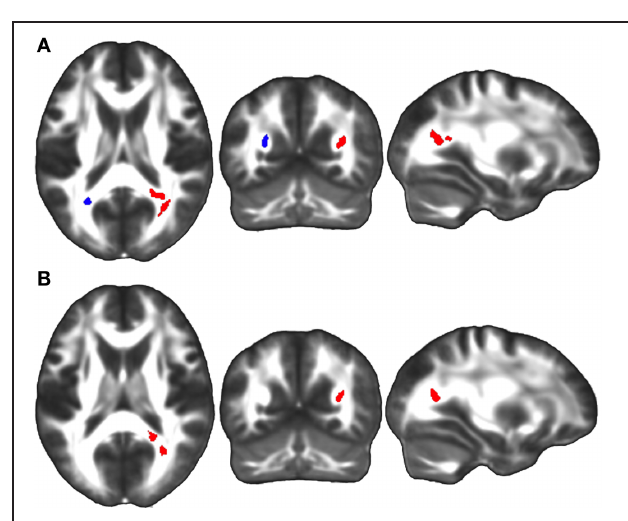
FIGURE 8 | (A) Linear regression analyses demonstrated a significant positive correlation between TBI patients’ performance on the Trails A visuomotor speed task and FA in bilateral regions of the sagittal stratum at the first time point (red), and in a unilateral region of the left sagittal stratum at the second time point (overlapping blue region). (B) A positive correlation was also observed between change in Trails A score between the first and third time points and change in sagittal stratum FA over the same four year study duration (red). The left side of the statistical map is patient left and right is patient